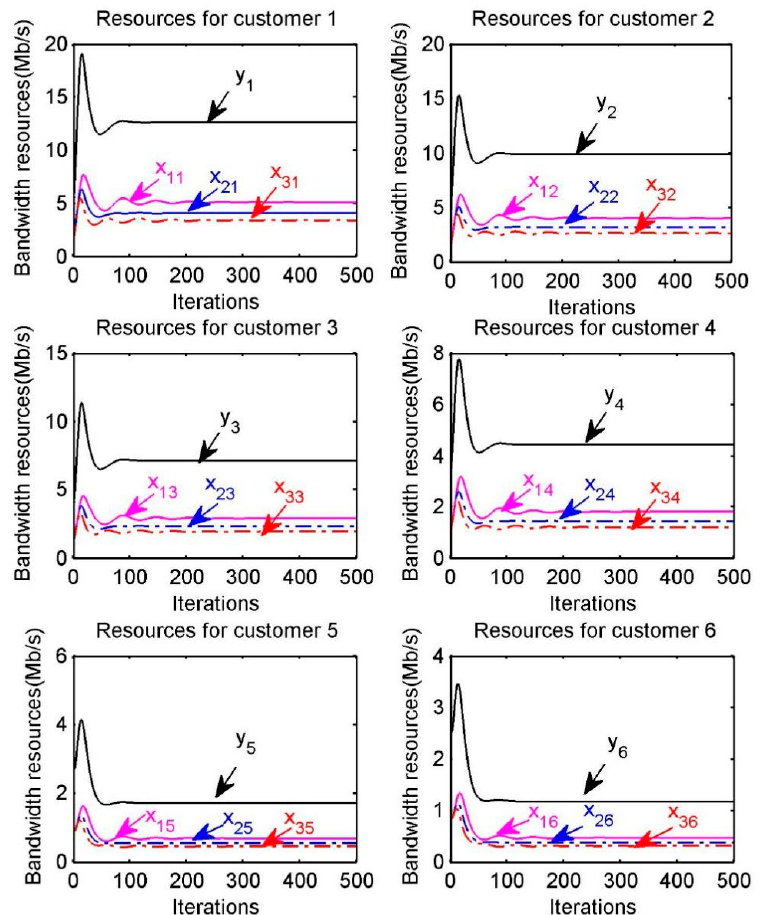
Figure 5. Optimal bandwidth resource allocation for customer 𝑠 .